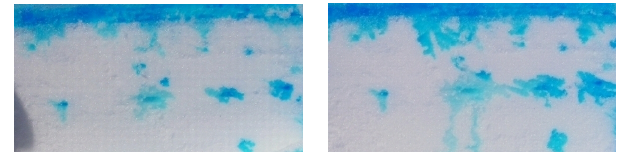
Fig. 2. Response of water flow in a slope. Shown are 50 cm wide frontal views of the pit-wall facing down-slope in experiments using dye-tracers. The left photo was taken immediately after cutting a pit-wall, the right picture approximately 30 s later. The size of the wet area at the pit-wall increased rapidly due to water flowing from lateral flow channels into the pit-wall.